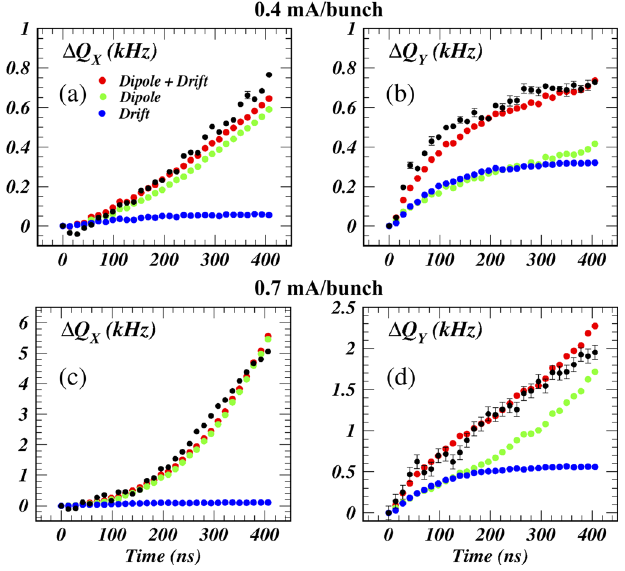
FIG. 29. Comparison of the measured (black points) and modeled tune shift values for the 2.1 GeV, 30-bunch train of positrons. The top row shows the tune shift values in the (a) horizontal and (b) vertical planes for a bunch population of 0 . 64 × 10 10 ( 0 . 4 mA = bunch). The bottom row shows the tune shift values in the (c) horizontal and (d) vertical planes for a bunch population of 1 . 12 × 10 10 ( 0 . 7 mA = bunch). Contributions from the field free regions of the ring are shown in blue; those from the dipole regions are shown in green. The sum of the two contributions is shown in red. Bunches are spaced 14 ns